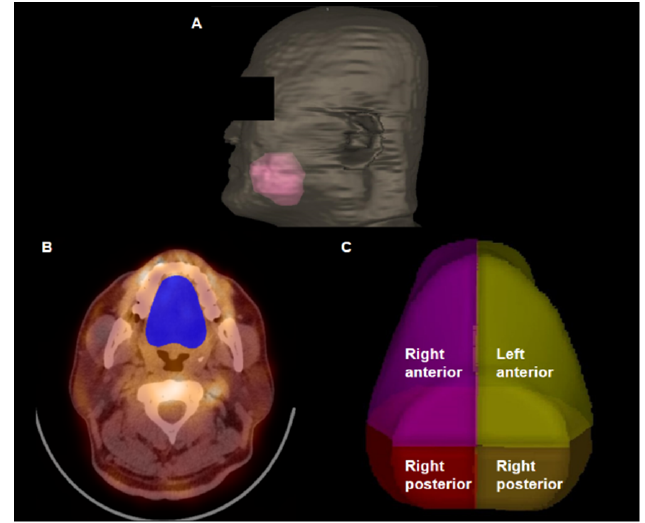
Figure 3. A volume rendering computed tomography image ( A ) and transaxial images ( B , C ) of volumes-of-interest of the tongue. The whole tongue area was delineated using a radiation treatment planning software (pink color on ( A ) and blue color on ( B )). The whole tongue area was divided into four quadrant areas ( C ). Maximum standardized uptake value and total tongue uptake of the whole tongue and four quadrant areas were calculated using these volumes of interest.